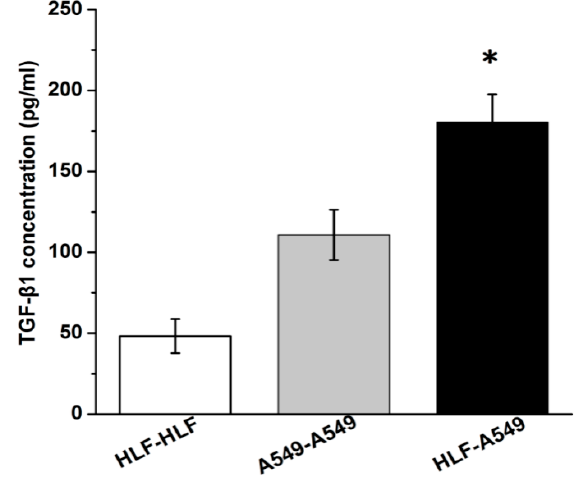
Figure 7. Transdifferentiation of HLF. α -SMA (green fluorescence) was used to identify activation of normal fibroblasts and the nucleus was stained blue by Hoechst 33342 (blue fluorescence). HLF could express more α -SMA after 48 h co-culture with A549 (green fluorescence). Scale bar = 50 μ m.